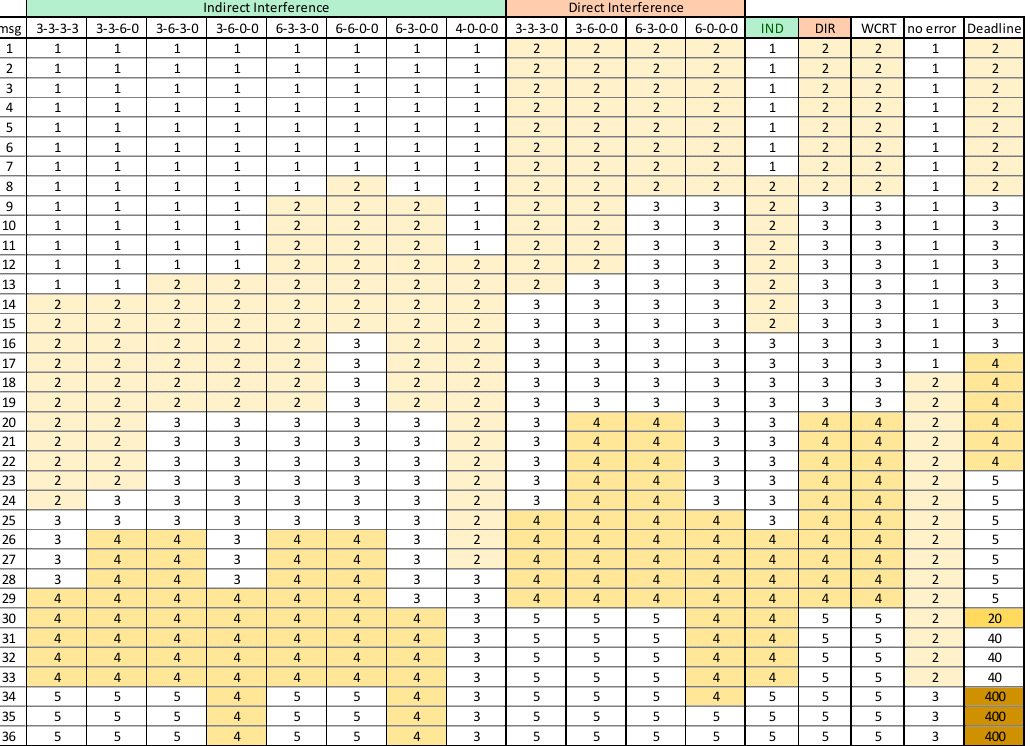
Figure 9. Response time for every message in the Updated_SAE set, using each possible interference pattern, when considering Indirect and Direct Interference.